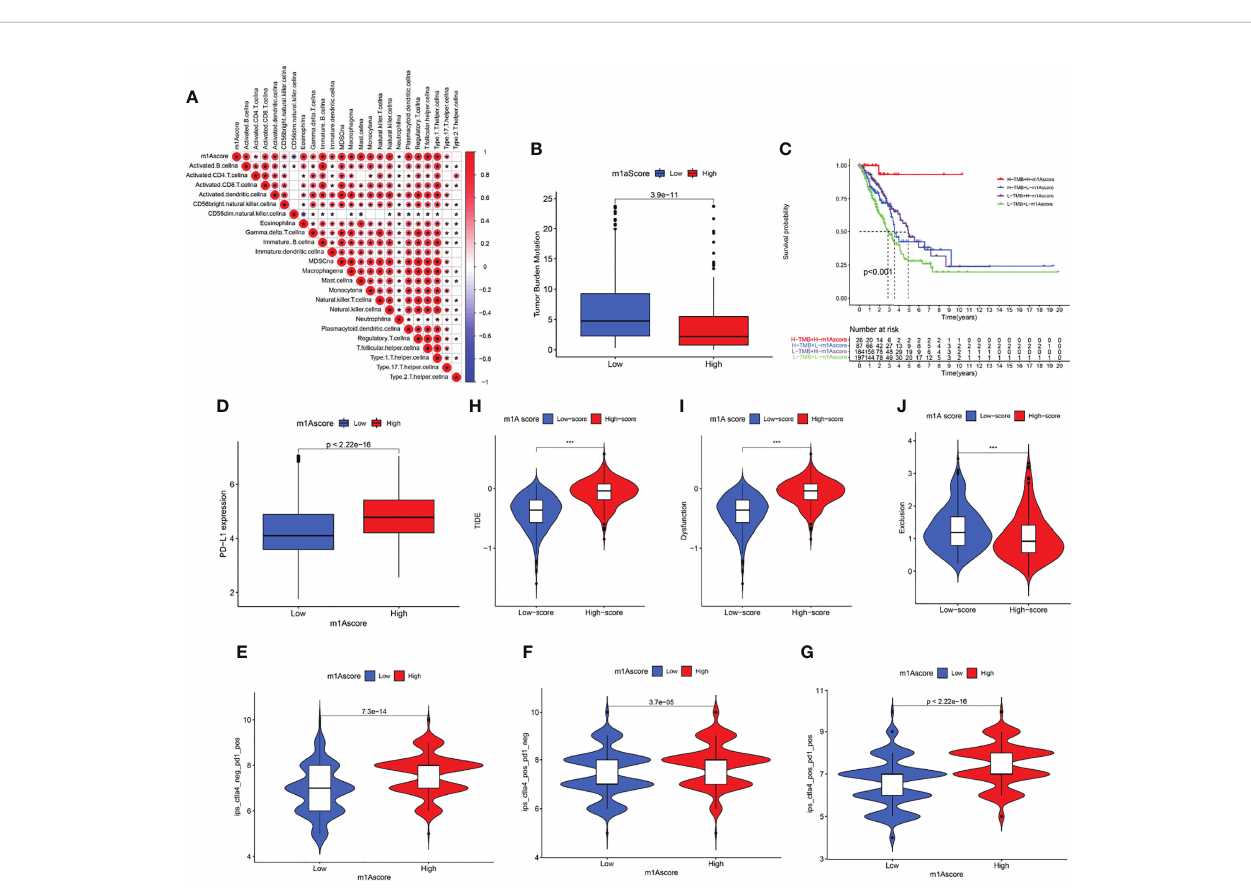
FIGURE 7 | Pro fi leofdifferencesinthe immunemicroenvironmentindifferentm1Ascoregroups. (A) Correlationbetweenm1Ascoreandimmune-relatedcellular components. Blueindicatesnegativecorrelation;redindicatespositivecorrelation;* indicatesP< 0.05. (B) ComparisonsofTMBscoreindifferentm1A scoregroups. (C) Overallsurvival analysisofdifferent m1A score andTMBscoregroups. (D) PD-L1 expressionlevelsindifferentm1Ascoregroups. (E – G) TreatmenteffectsofCTLA-4or PD-1andcombined CTLA-4andPD-1wereevaluatedinpatientswithhighandlowm1Ascores. (H – J) TIDE, dysfunction,